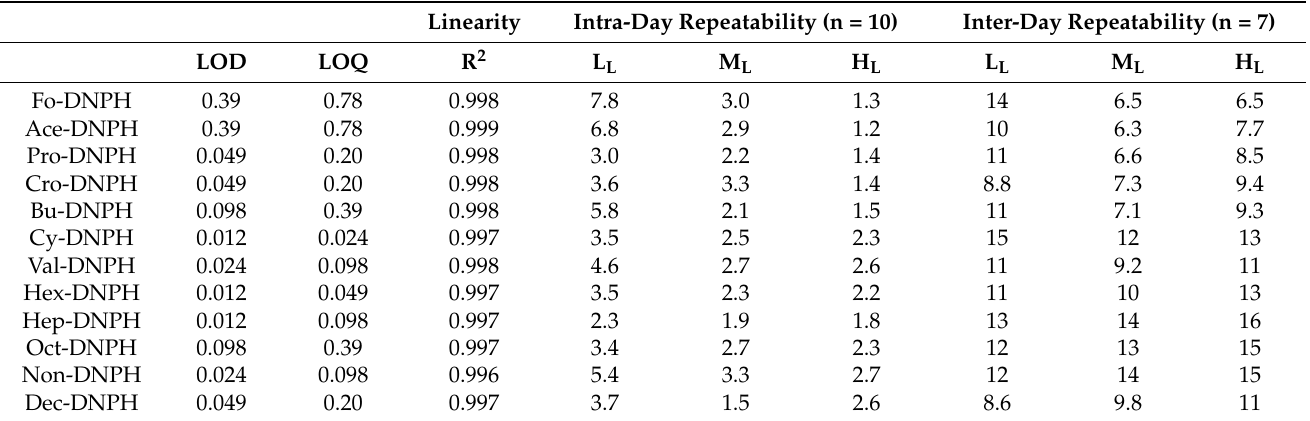
Table 3. LODs ( µ g L − 1 ), LOQs ( µ g L − 1 ), linearity (R 2 ), and the intra- and inter-day repeatability (RSD%) that were obtained from the LC-MS/MS optimized method. L L , M L , and H L correspond